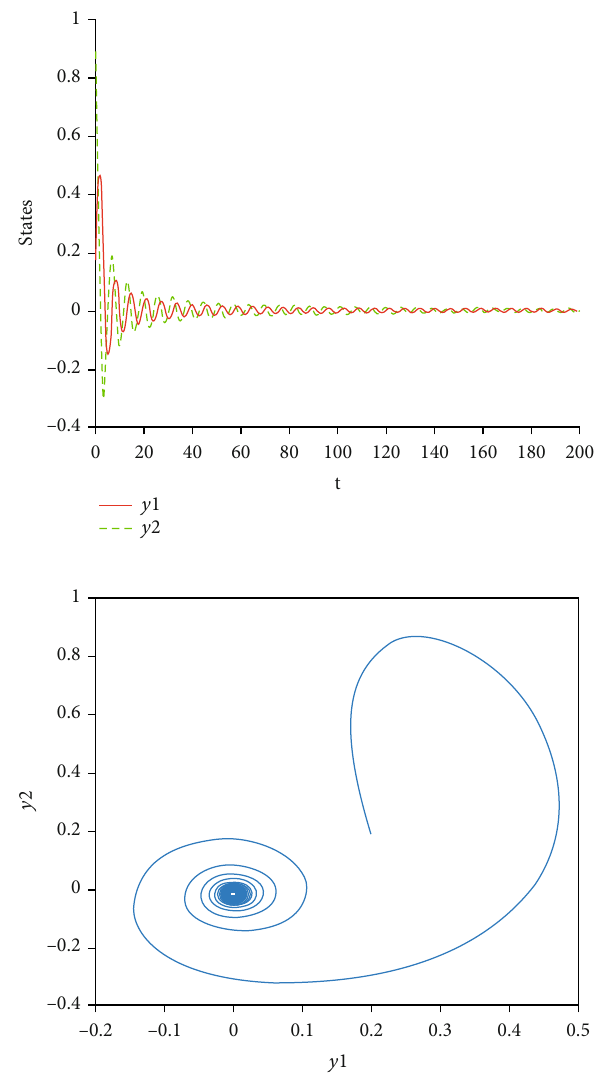
Figure 1: Numercial solution of Eq.